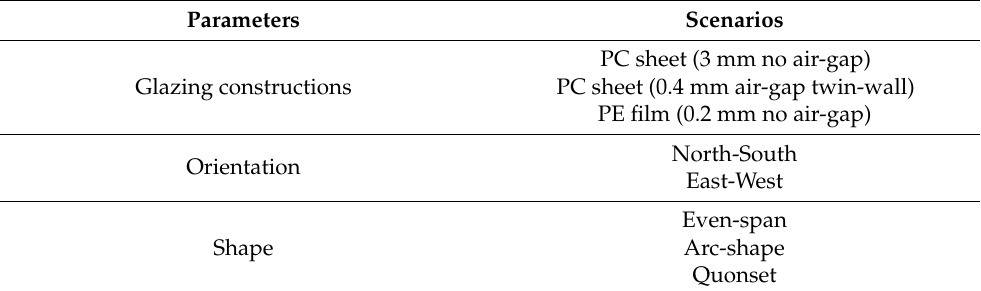
Figure 9. Ideal annual energy required for ( a ) heating and ( b ) cooling for the different shapes (using PC sheet (air-gap 9.2 mm) as the glazing material with an East-West orientation)). Table 2. Scenarios for the geometry and non-geometry parameters of the